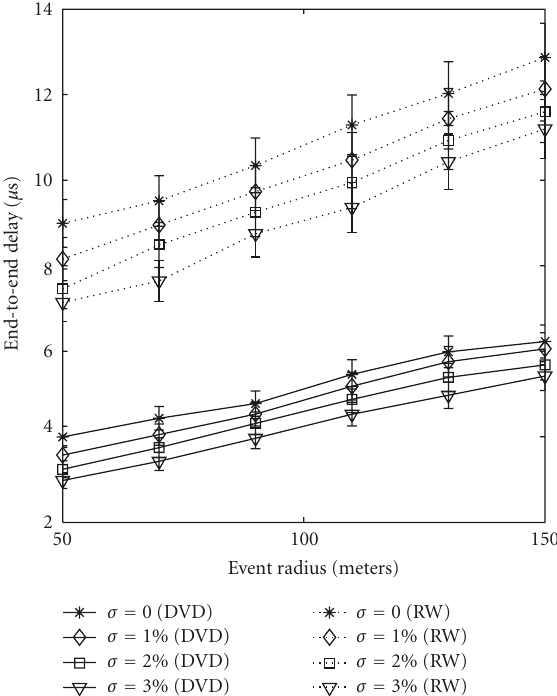
Figure 21: Sensitivity of Average number of hops for DVD and RW.